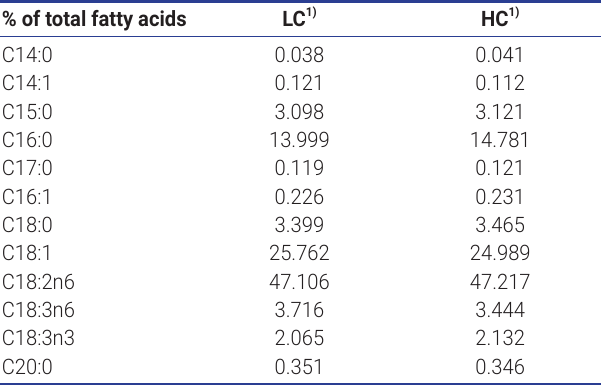
Table 2. Fatty acids composition of the